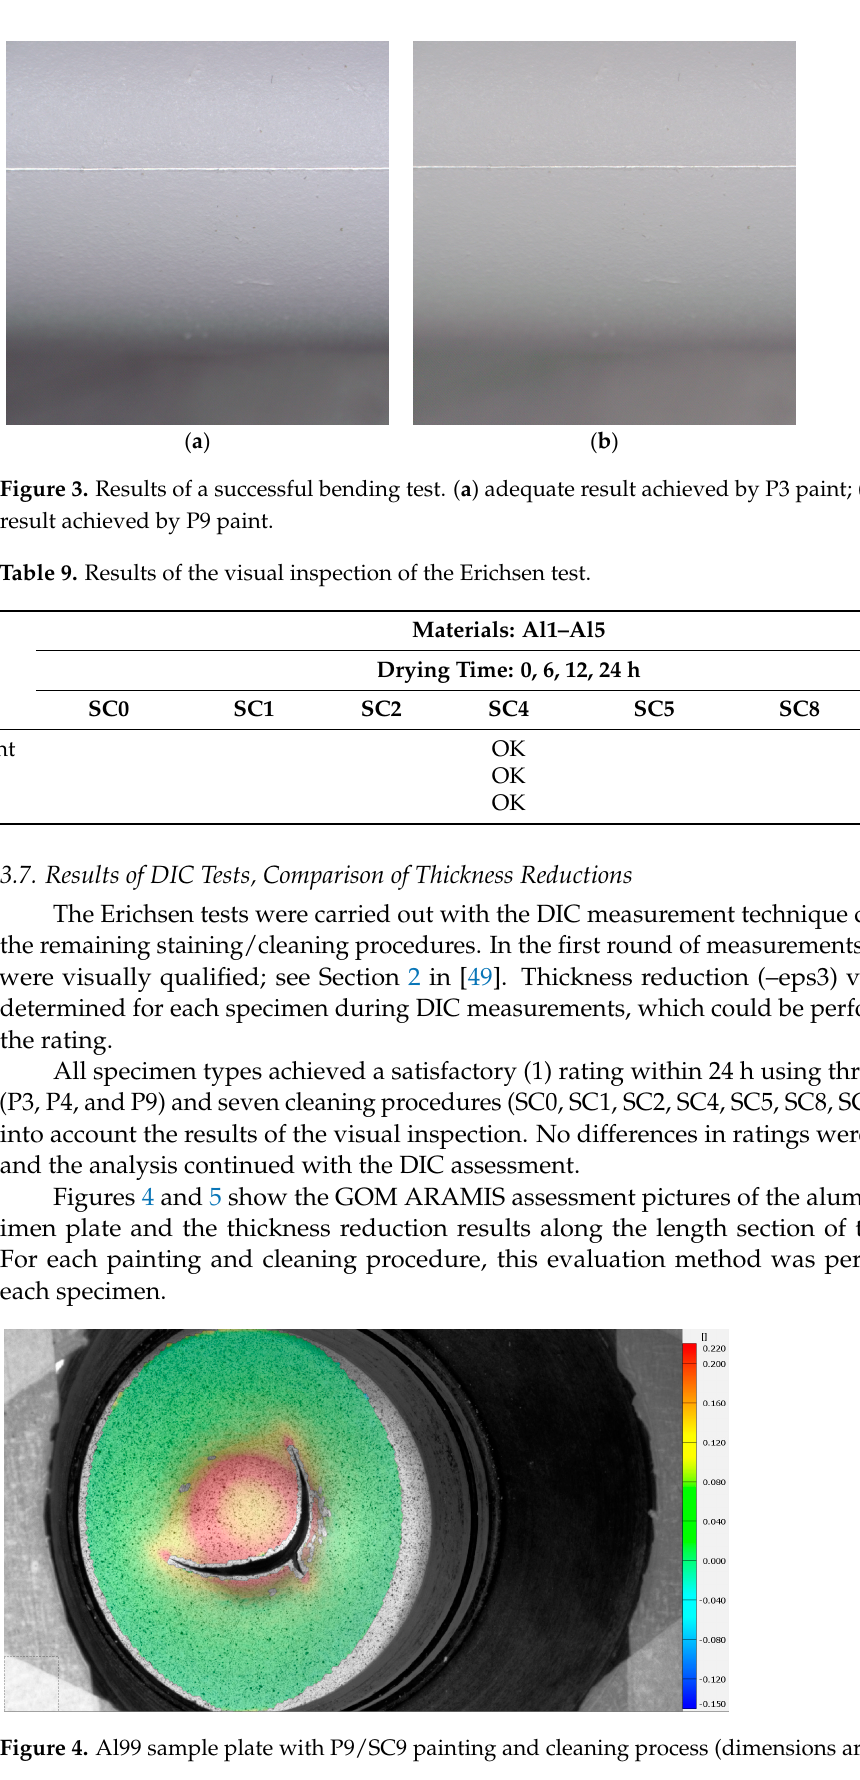
Figure 2. Microscopic images of paints. ( a ) P5’s and ( b ) P8’s. The photos (see Figure 2) show the paint peeling off, while Figure 3 shows the corresponding paint layers. It can be seen that good contact (adhesion) was achieved between the paint and the base aluminum plate (see Figure 3).